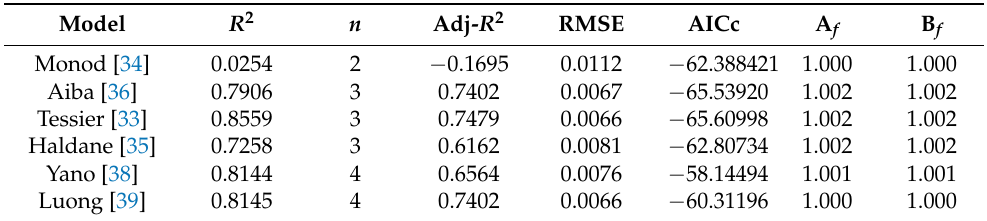
Figure 6. The effect of initial diesel concentration on the specific growth rate, µ , of consortium BS24, using OD 600nm as a proxy for microbial growth and the experimentally assessed and predicted specific growth rates fitted to selected mathematical models at different initial diesel concentrations. The error bars represent the mean ± standard deviation of experimental triplicates. Table 6. Statistical analysis of non-linear models applied for estimation of growth kinetics using consortium